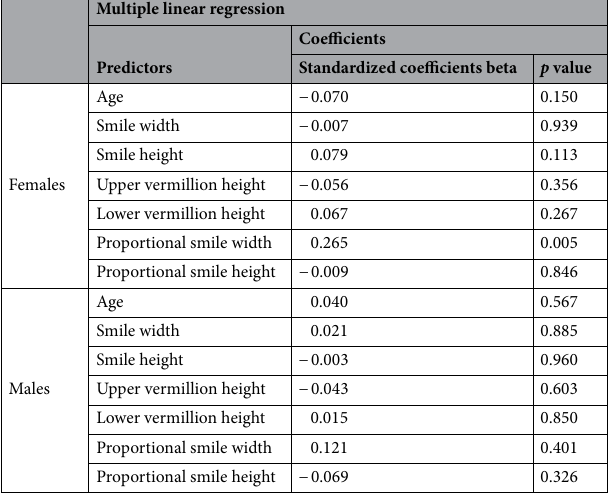
Multiple linear regression